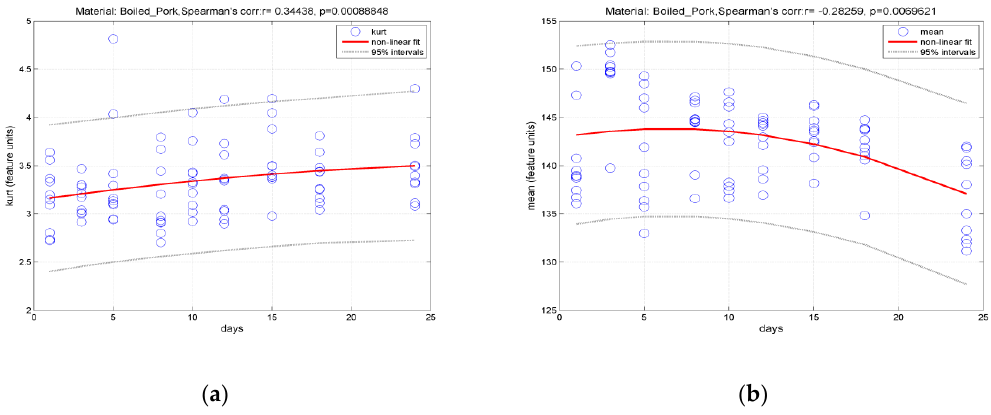
( a ) ( b ) Figure A2. Variation of features ( a ) kurtosis and ( b ) mean intensity value of smoked pork hams during refrigerator storage. ( a ) ( b ) ( c )